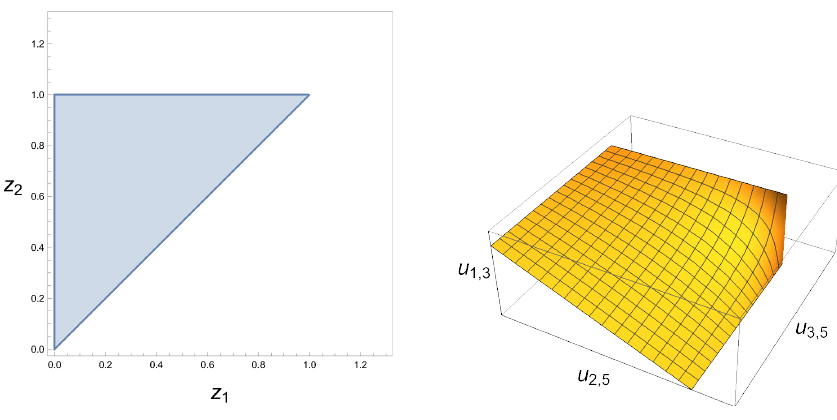
Figure 1. Different parameterizations of Gr + (2 , 5) /T . In the z -variable parameterization, only three boundaries are manifest. However, the u -variable parameterization makes all five boundaries